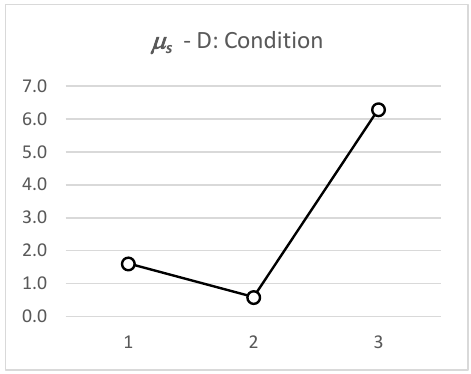
Figure 5. Factor D level effect on  s.